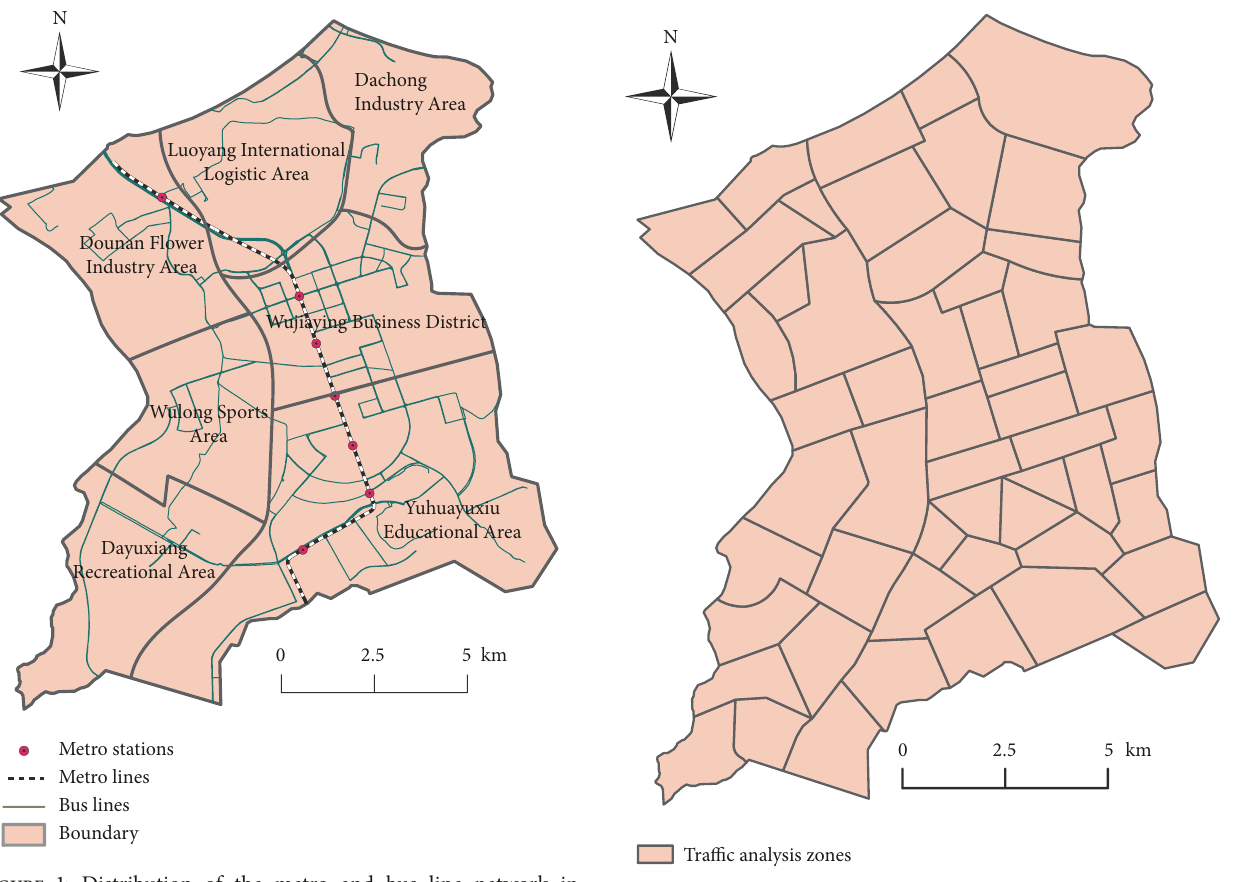
Figure 1: Distribution of the metro and bus line network in Chenggong New District. Figure 2: Division of Chenggong New District into traffic analysis